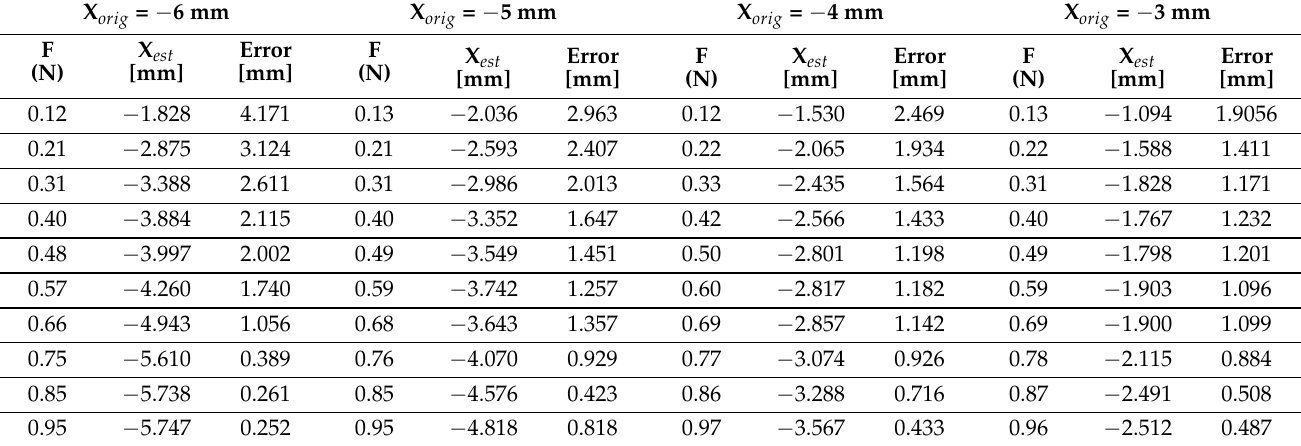
Table A2. Contact position estimation w.r.t linear × displacement under force ranges (0.1 N ∼ 1